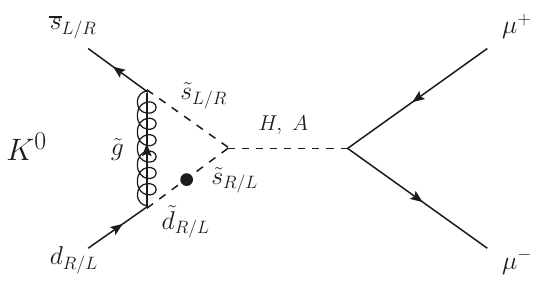
! (cid:22) + (cid:22) (cid:0) S